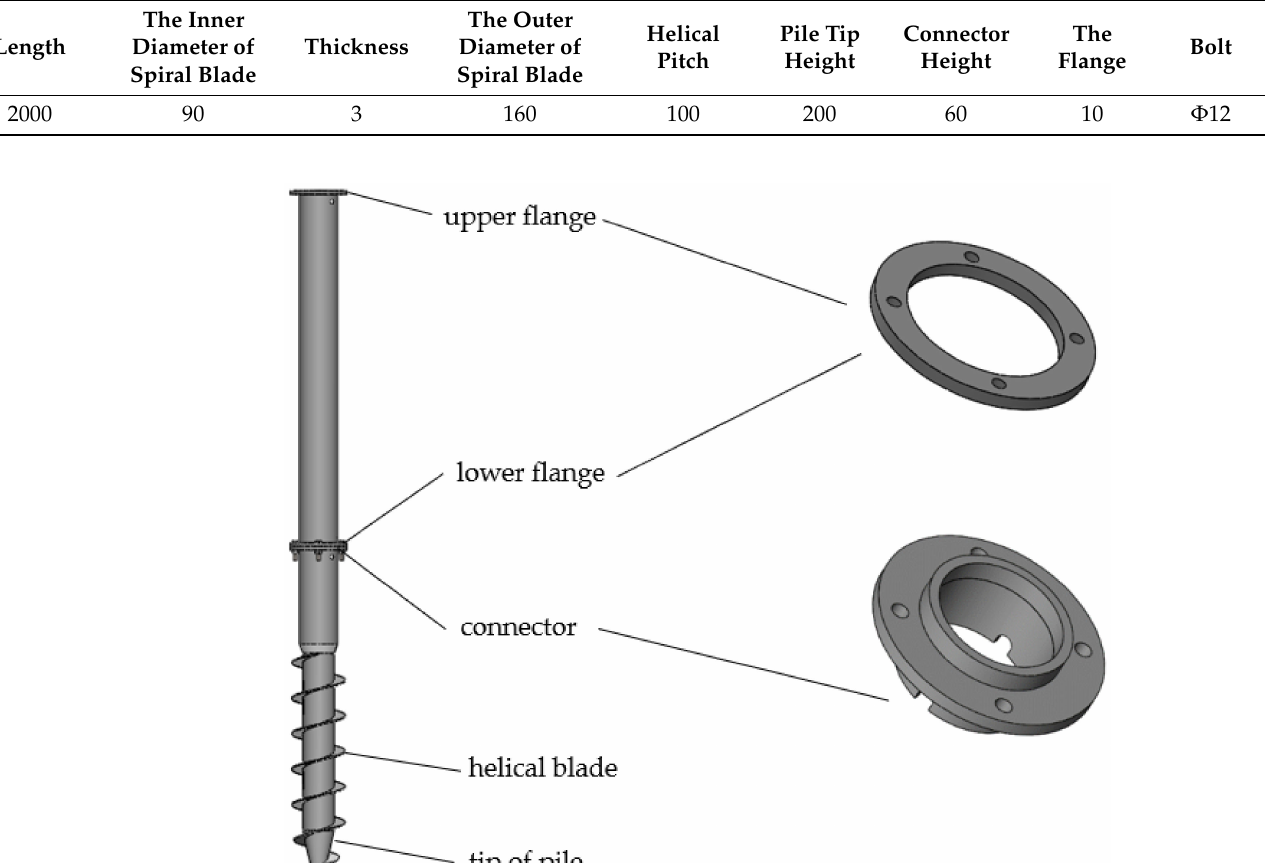
Table 1. Structural parameters of helical pile (unit: mm).